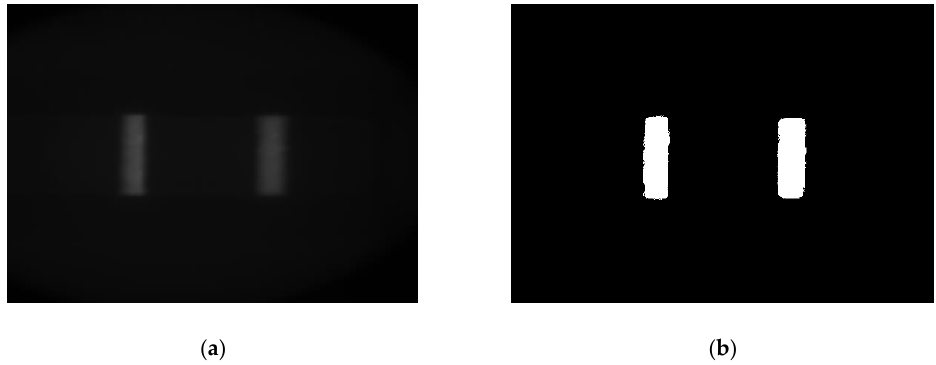
Figure 5. Results of image segmentation: ( a ) original image; ( b ) segmented image.